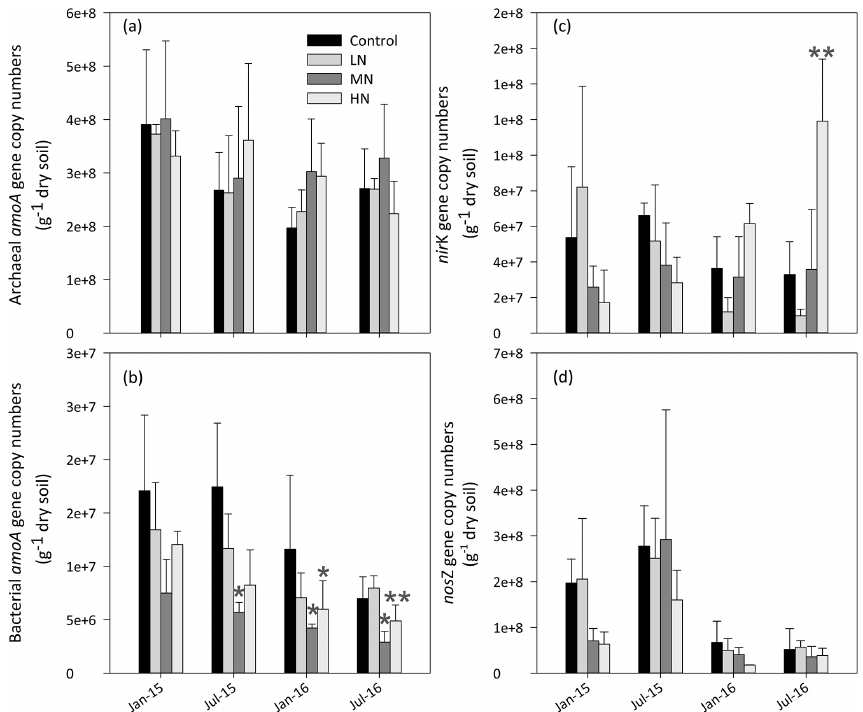
Figure 4. Responses of functional genes (AOA amoA , panel a ; AOB amoA , panel b ; nirK , panel c and nosZ , panel d ) to N deposition. Bars represent standard errors of the mean ( n = 3). Significance levels are indicated by ∗ P < 0 . 05, ∗∗ P < 0 . 01.